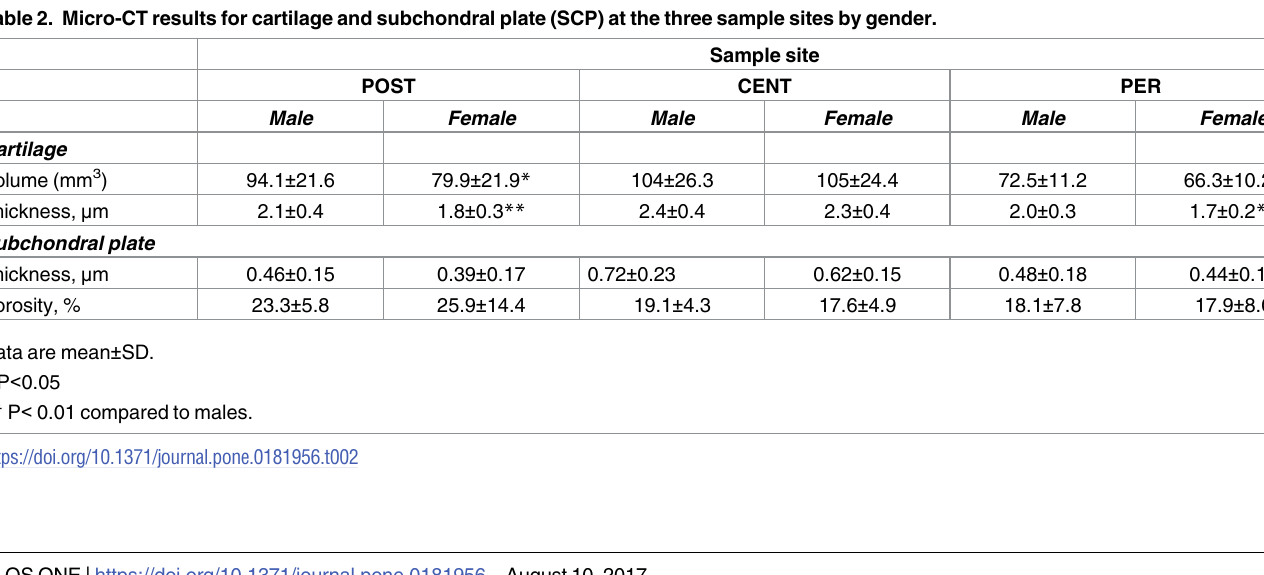
females at all sites (P = 0.03) as was BS/TV at the PER site (P = 0.04). SMI values were lower for males at the CENT site and DA values were lower at POST site.